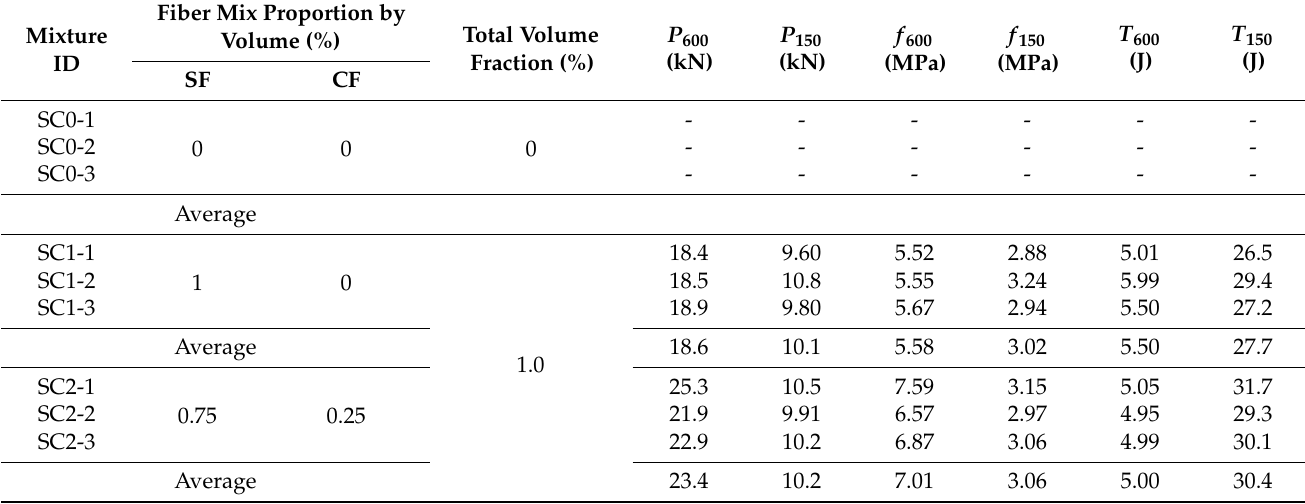
Table 5. Test results of flexural performance indices using ASTM C 1609 and KS F